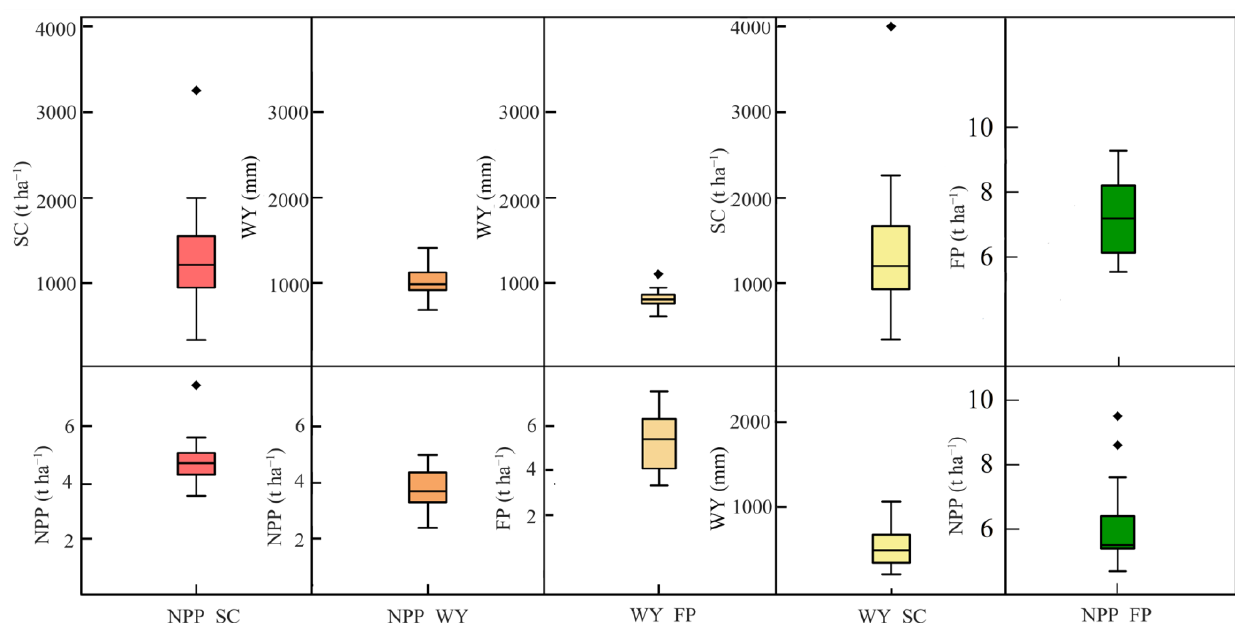
Figure 7. The box plots of thresholds on the constraint lines of NPP_SC, NPP_WY, WY_FP, NPP_FP and WY_SC. NPP: net primary productivity; FP: food production; SC: soil conservation; WY: water yield. Diamond represents outliner. Table 4. The thresholds, slopes (k) and constant terms (b) of FP_SC, FP_WY, WY_SC, NPP_WY and